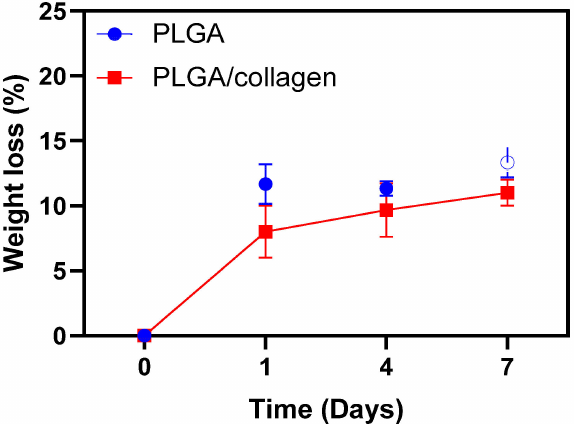
Figure 4. Weight loss of PLGA and PLGA/collagen scaffolds in the time exposed to enzymatic degradation with